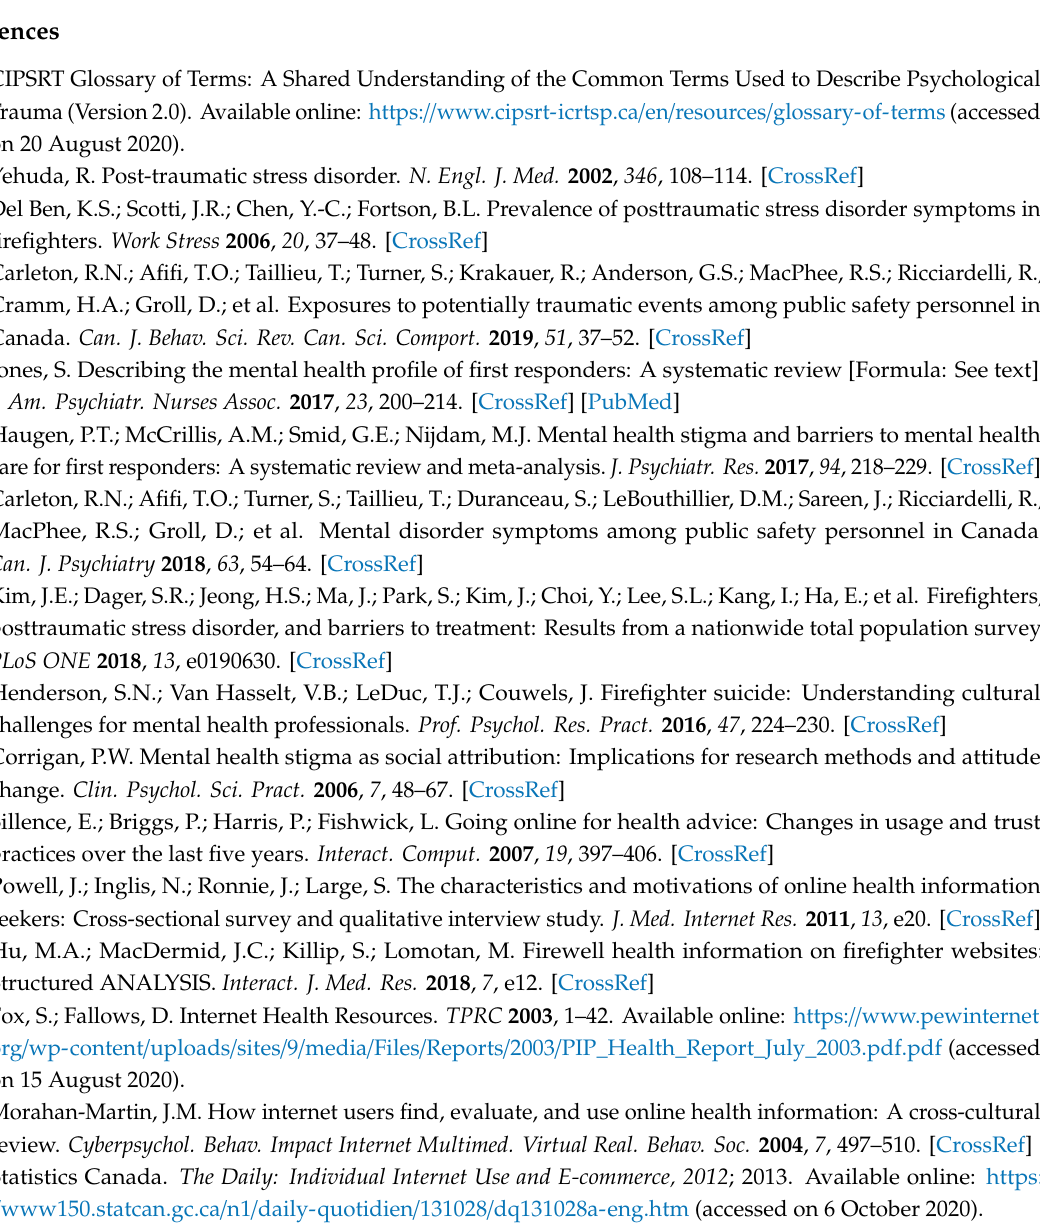
Table S3: Evidence-based